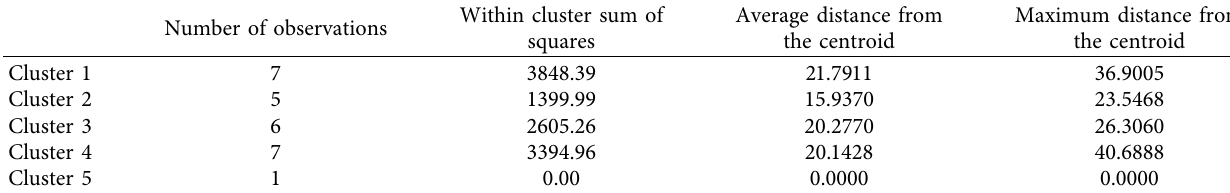
Table 7: Distance between clusters of 26 genotypes.